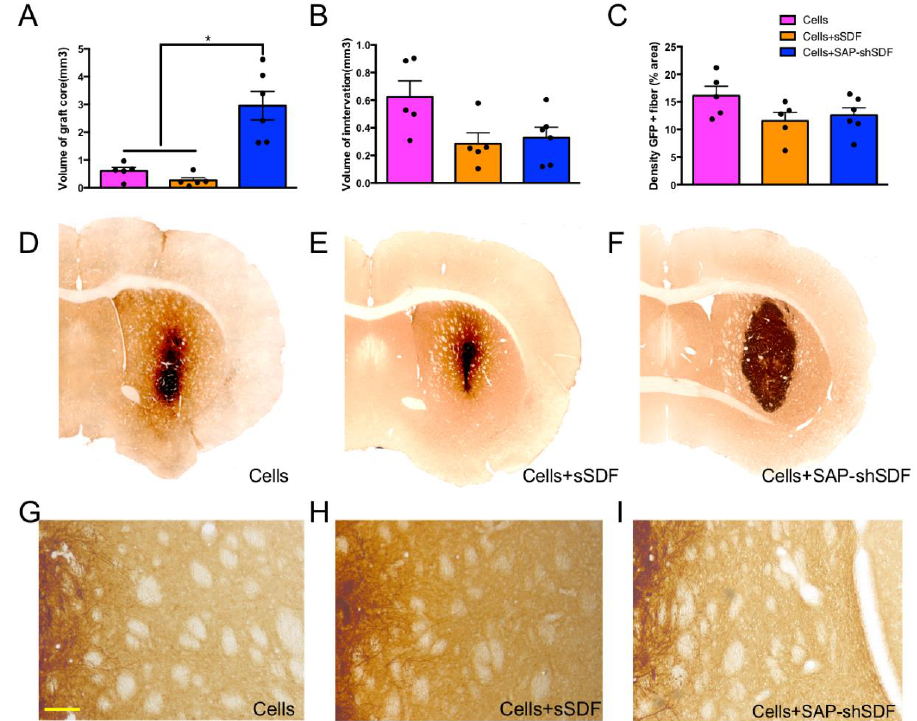
Figure 3. Homeostatic hydrogel supports graft growth. ( A ) volume of graft core, ( B ) volume of graft innervation within host, ( C ) quantification of GFP fiber density, ( D – F ) representative photomicro- graphs providing a coronal view of GFP+ graft and innervation of GFP+ graft in all groups, ( G – I ) representative images of GFP+ fiber obtained adjacent to the graft in all groups, scale bar = 100 μ m. Data represent mean ± standard error of the mean (SEM; *, p < 0.05).